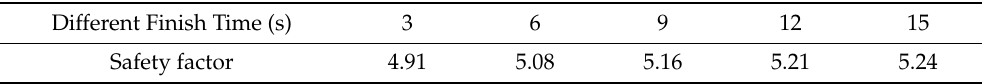
Table 4. Safety factors for different pump shutdown times (Uniform tubing diameter of 3-1/2 (cid:48)(cid:48) , inside pressure of 10 MPa).